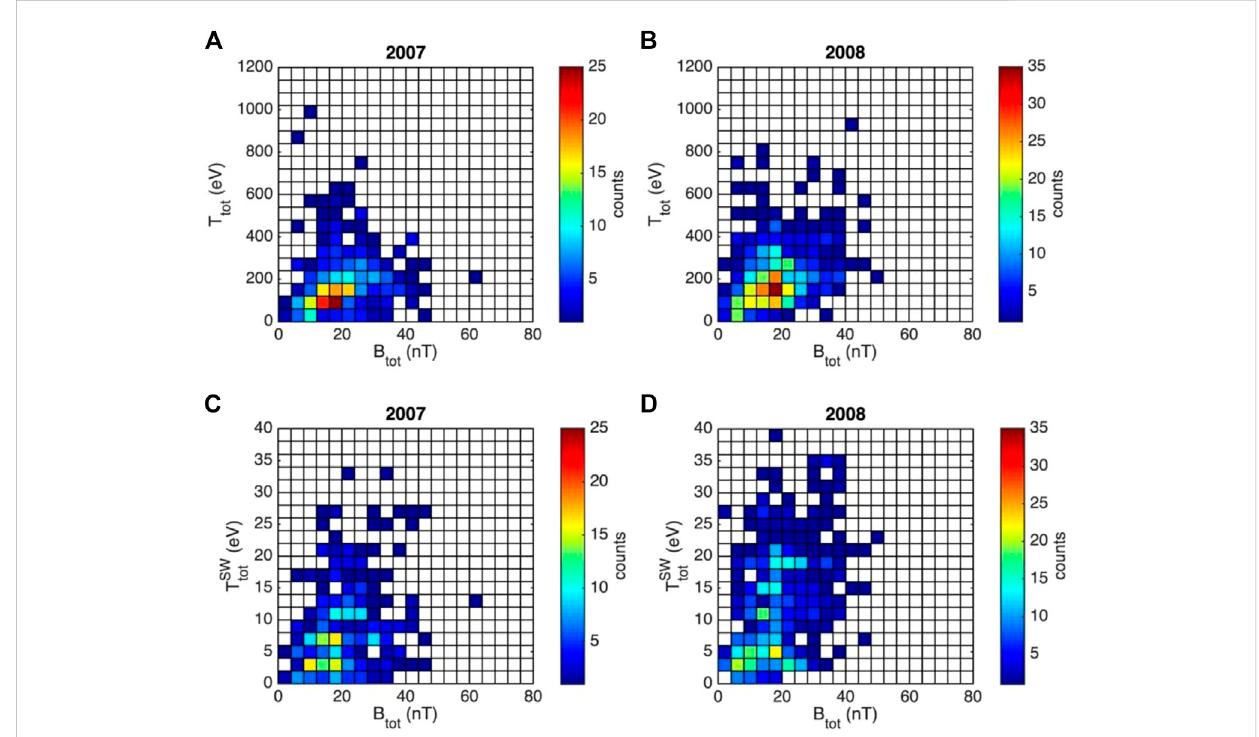
FIGURE 12 Upper row: 2D histograms in the space de fi ned by the jet ion total temperature computed as T (cid:1) 2 3 T per + 1 3 T par and the jet magnetic fi eld (A) for 2007 and (B) for 2008. Bottom row: 2D histograms de fi ned in the space de fi ned by the solar wind ion total temperature measured by ACE and the jet magnetic fi eld (C) for 2007, and (D) for 2008. Only one value per jet is considered, the one at maximum of the dynamic pressure (see Figure